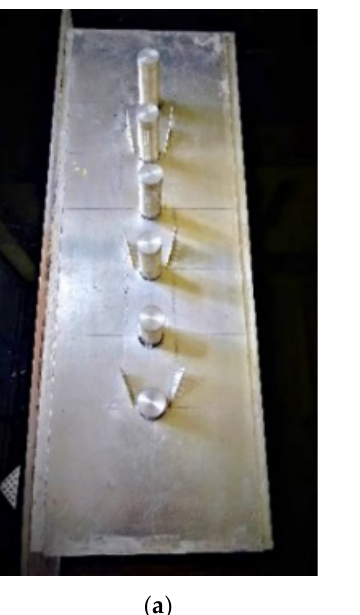
Figure 2. Geometry of the test specimen: ( a ) top view of three pairs of in-line PDW and PCDW VGs; ( b ) side view of three pairs of in-line PDW and PCDW VGs; ( c ) geometry of the perforated VG.